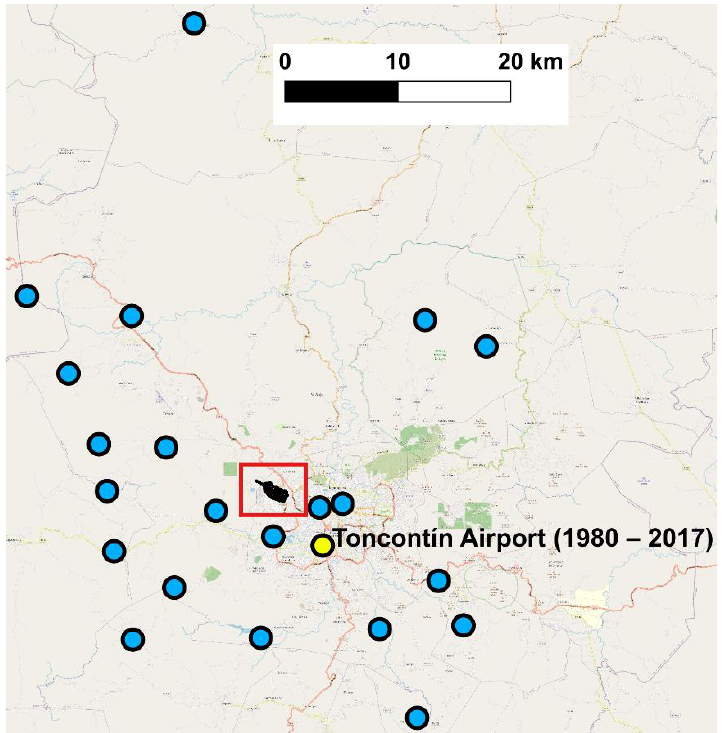
Figure 4. Precipitation gauges in the vicinity of Tegucigalpa. The gauge at the Toncontín Airport is highlighted in yellow color.